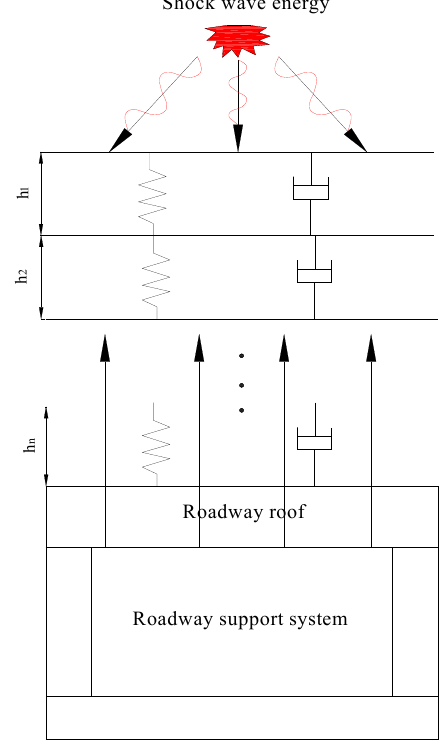
Figure 13. Simplification of the Figure 13. Simpli fi cation of the model.